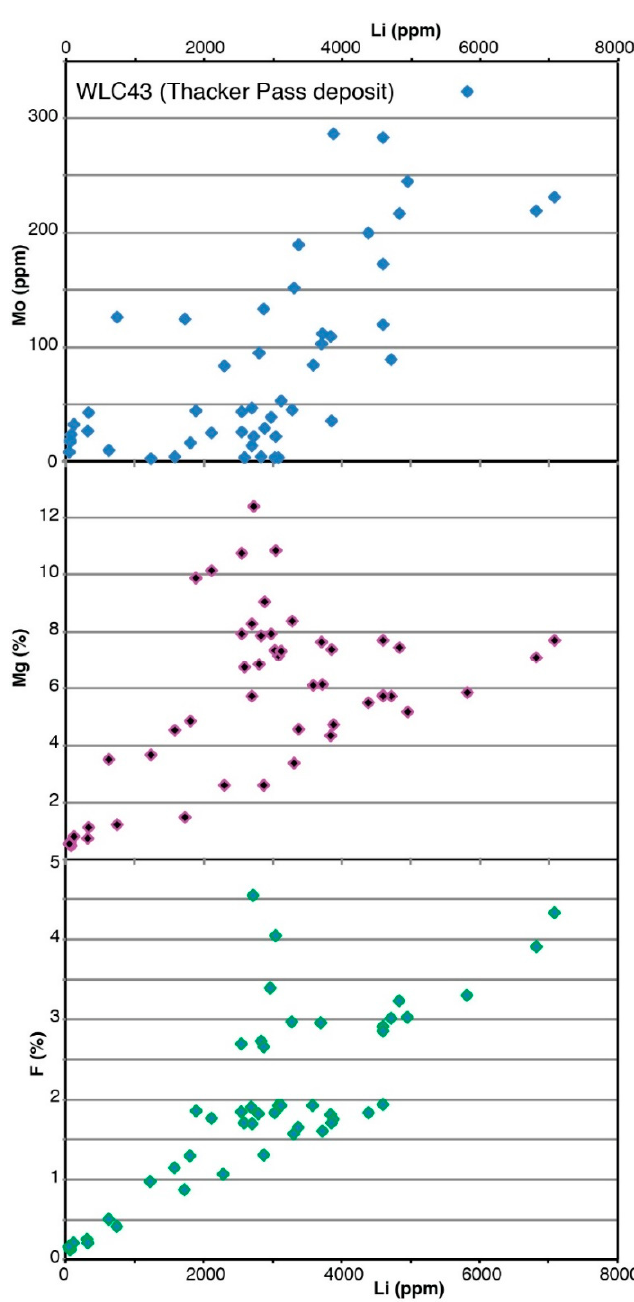
Figure 13. Plots of Li versus Mo, Mg, and F for bulk 1.5 m interval samples and select hand samples from WLC43. Crude positive correlation between Li and Mo suggests similar depositional mechanism for the two elements but that they probably occur in different minerals. The nearly linear correlation between Li and Mg for most samples suggests inclusion in the same mineral (the clay phases) while high Mg outliers probably indicate the presence of dolomite. The same relationship is shown between Li and F with high F outliers likely due to the presence of